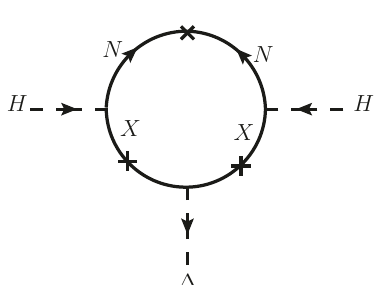
Figure 1 . One-loop Feynman diagram for producing the H T i(cid:28) 2 (cid:1) y H term, where the cross symbols denote the mass insertions of the N and X leptons.